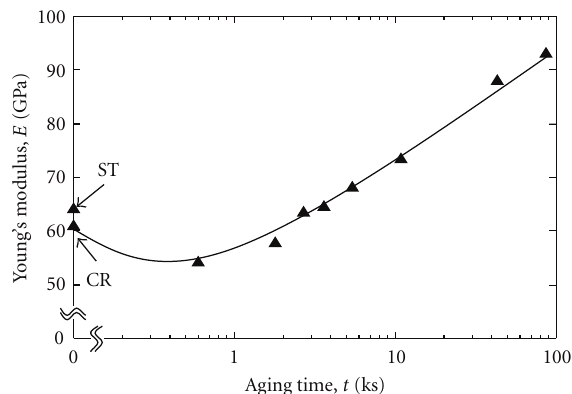
Figure 6: Young’s moduli of ST, CR, and AT samples as a function of aging time.